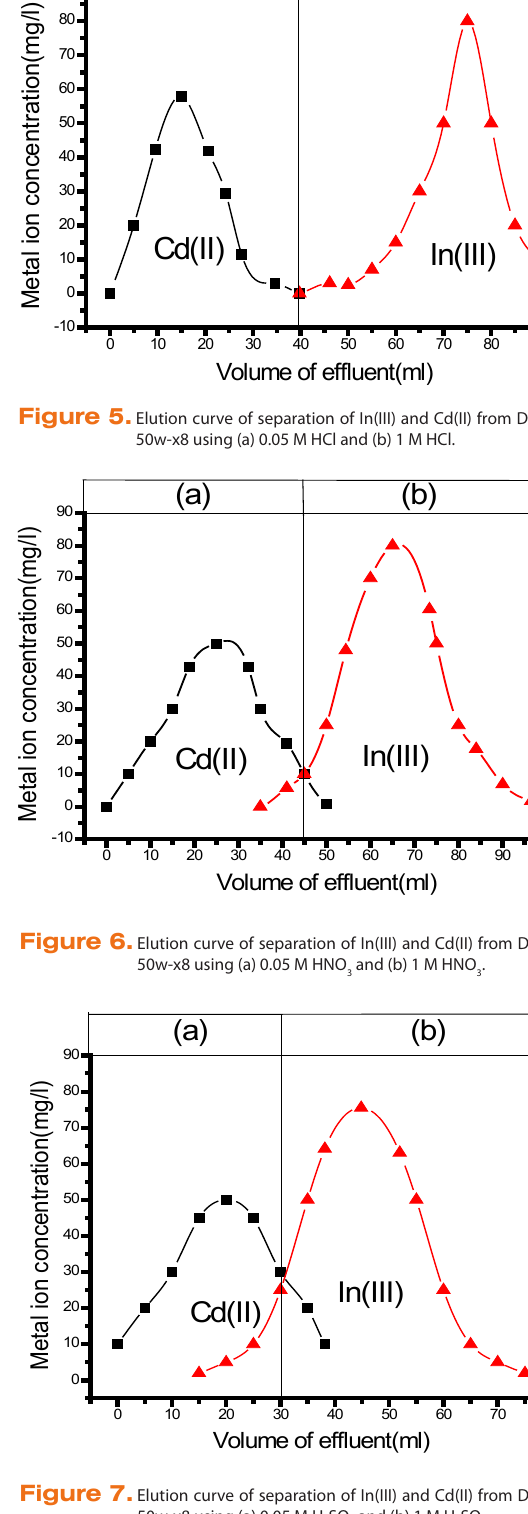
50w-x8 using (a) 0.05 M H